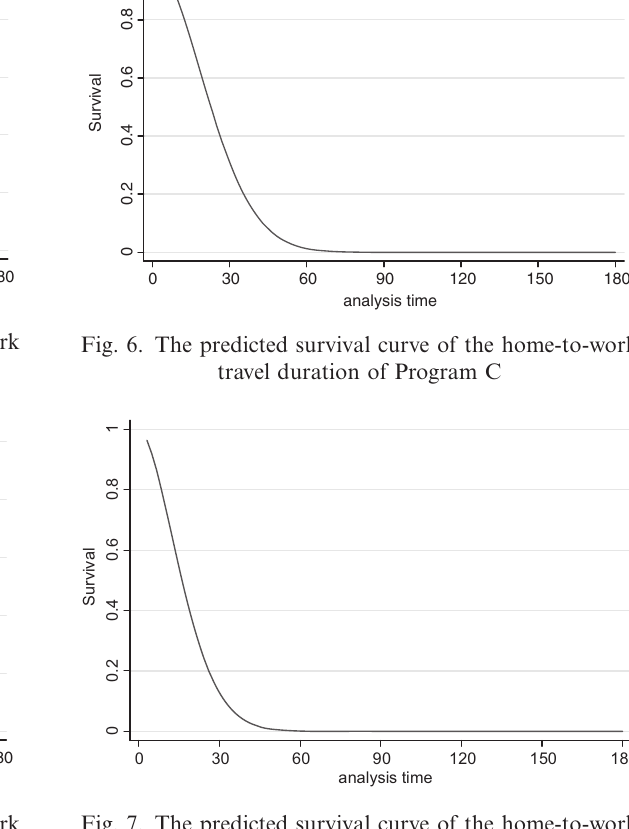
Fig. 7. The predicted survival curve of the home-to-work travel duration of Program